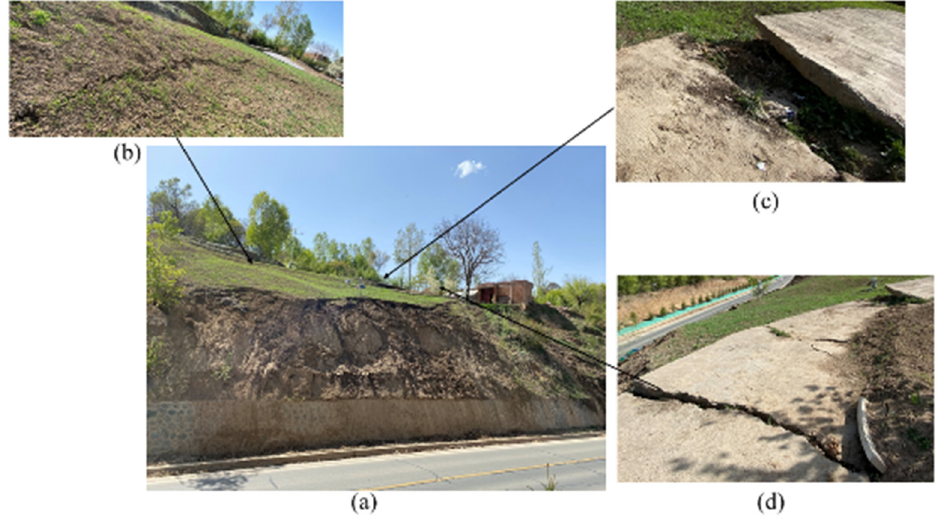
Figure 7. ( a ) Study area and photos showing Lashagou NO. 3 landslide disease. ( b ) ground fracture ( c ) staggered platform ( d ) tensile crack caused by the landslide. Table 2. Parameters of Leica P50 3D laser scanner [60].